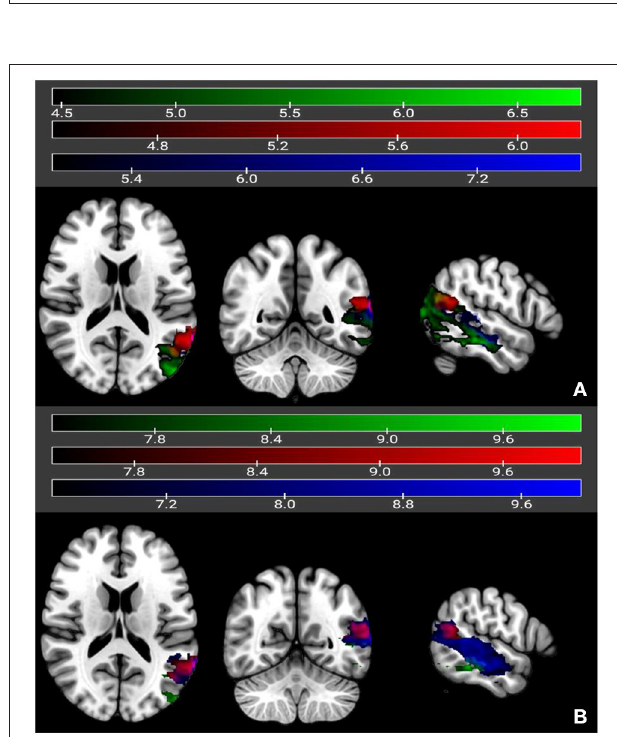
FIGURE 2 | Univariate (A) and multivariate (B) LSM maps showing neural correlates of yes/no questions (in dark blue), single-word comprehension (in green), and sequential commands (in red). Regions overlapping between single-word comprehension and yes/no questions are in light blue, and regions overlapping between single-word comprehension and sequential commands are in magenta. Regions overlapping across all three subtests are in yellow. Color bars reflect t